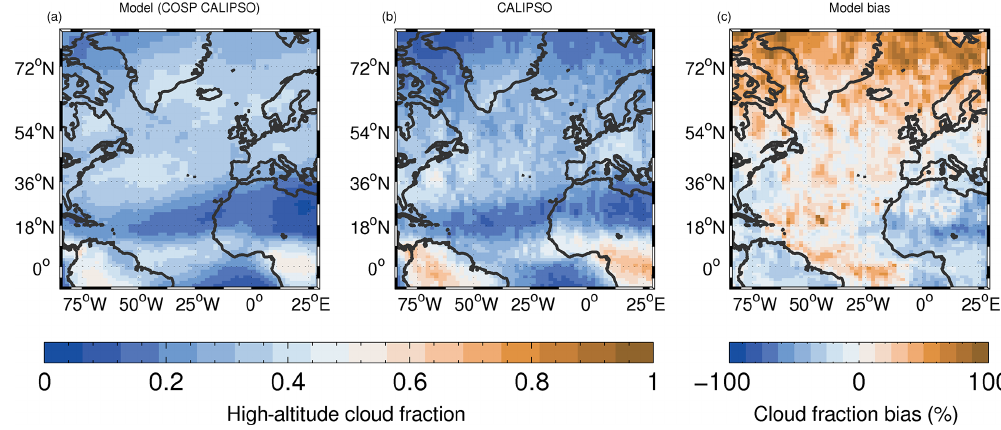
Figure 3. As for Fig. 1 except for high-altitude clouds (CTP < 440hPa).